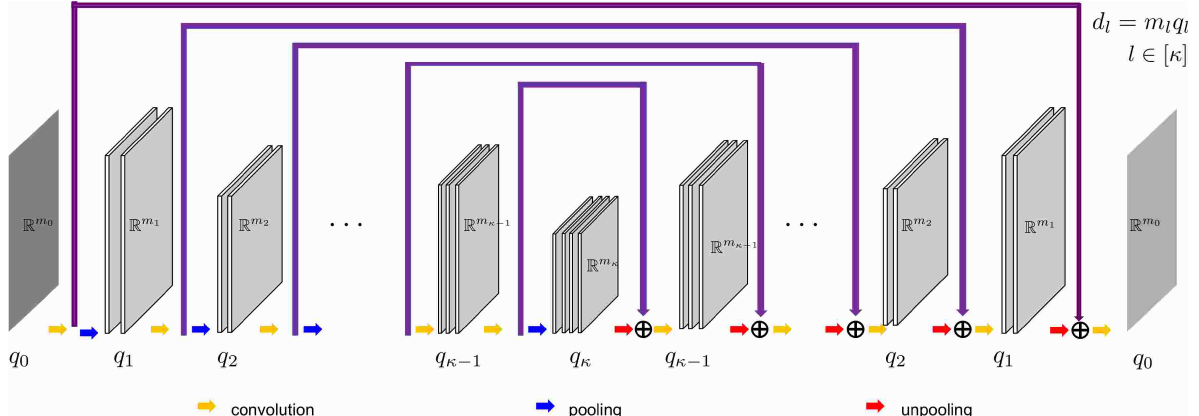
Figure 7. An encoder–decoder CNN architecture with κ layers and skip connections; q l refers to the number of channels, m l denotes each channel dimension, and d l depicts the total dimension of the feature at the l -th layer. Source: